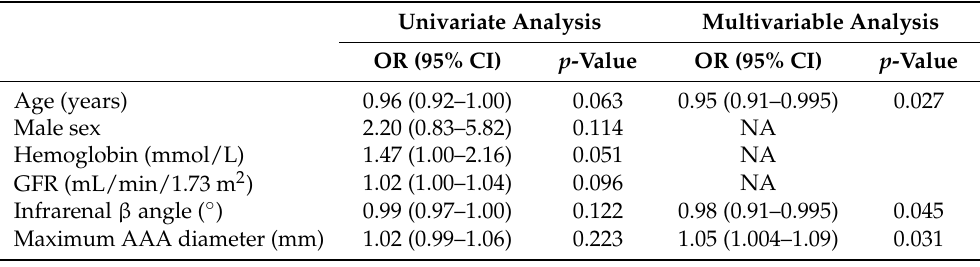
Table 3. Logistic regression analysis of baseline characteristics for AAA sac